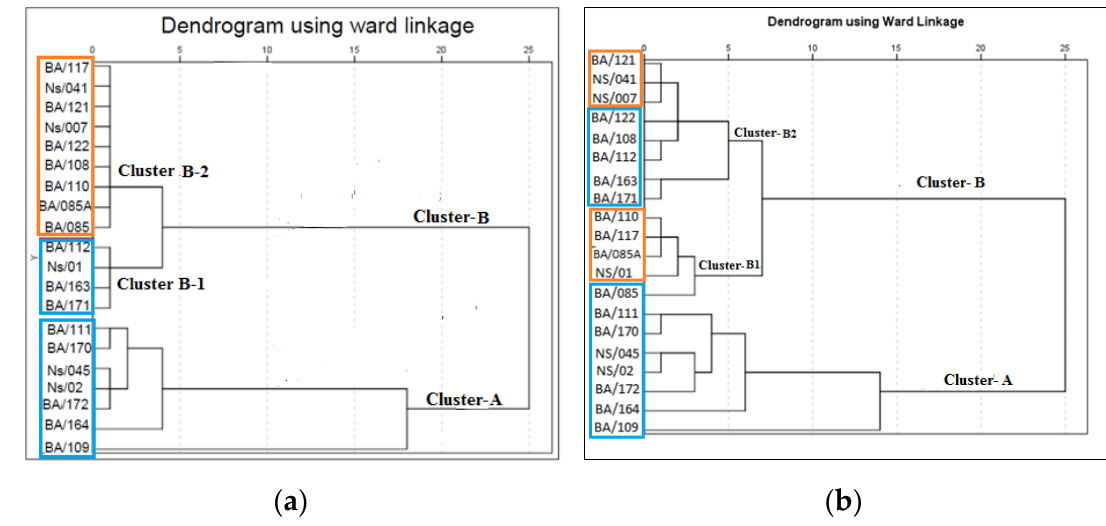
Figure 9 . ( a ) Dendrogram resulting from the hierarchical cluster analysis (HCA) in Q-mode applied to rock samples; classification is based on major and trace elements ( n = 55). ( b ) Dendrogram resulting from the HCA in Q-mode applied to groundwater samples; classification is based on major and trace elements ( n = 20). The blue group represents the calcite dissolution, and the orange group represents the dolomite dissolution.